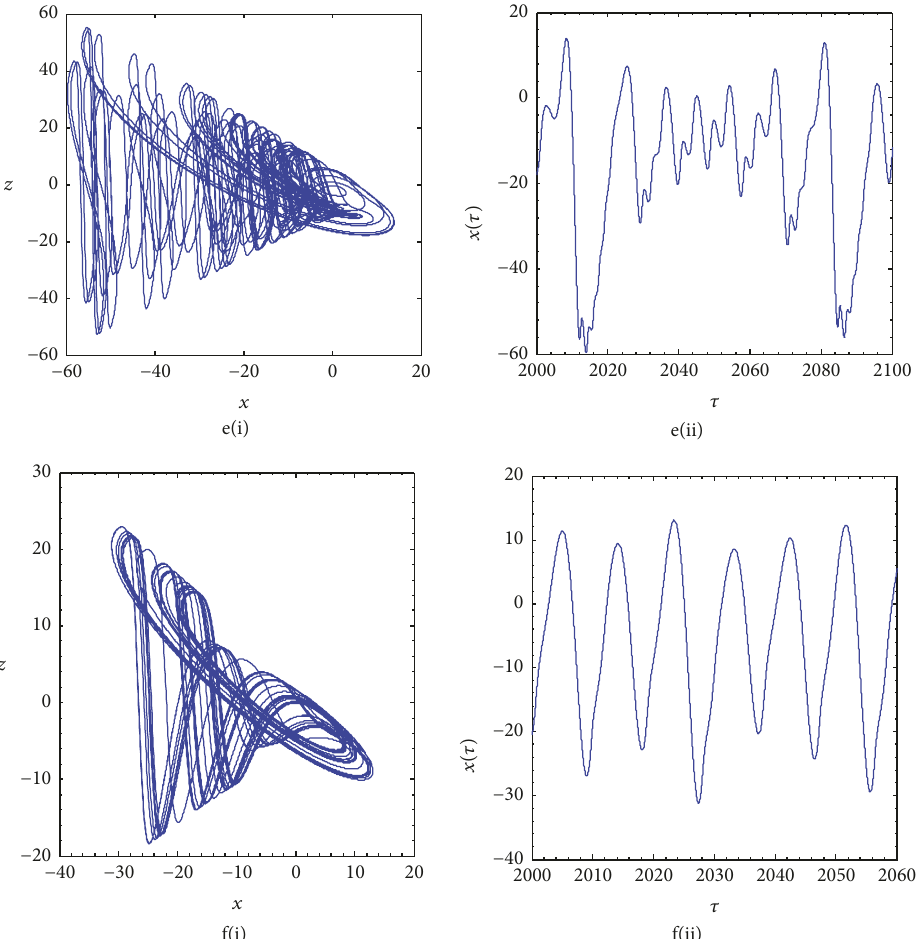
Figure 3: Numerical phase portraits in 𝑋𝑍 plane (left) of the system showing routes to chaos (in terms of the control parameter 𝜇 ) and corresponding time traces (right) of the coordinate 𝑥(𝜏) for varying 𝜇 : (a) period-1 cycle for 𝜇 = 0.165 ; (b) period-2 cycle for 𝜇 = 0.381 ; (c) period-4 cycle for 𝜇 = 0.385 ; (d) spiralling-like (Feigenbaum) chaotic attractor for 𝜇 = 0.406 ; (e) screw-like (Shilnikov) chaotic attractor for 𝜇 = 0.420 ; (f) another screw-like (Shilnikov) chaotic attractor for 𝜇 = 1.100 .